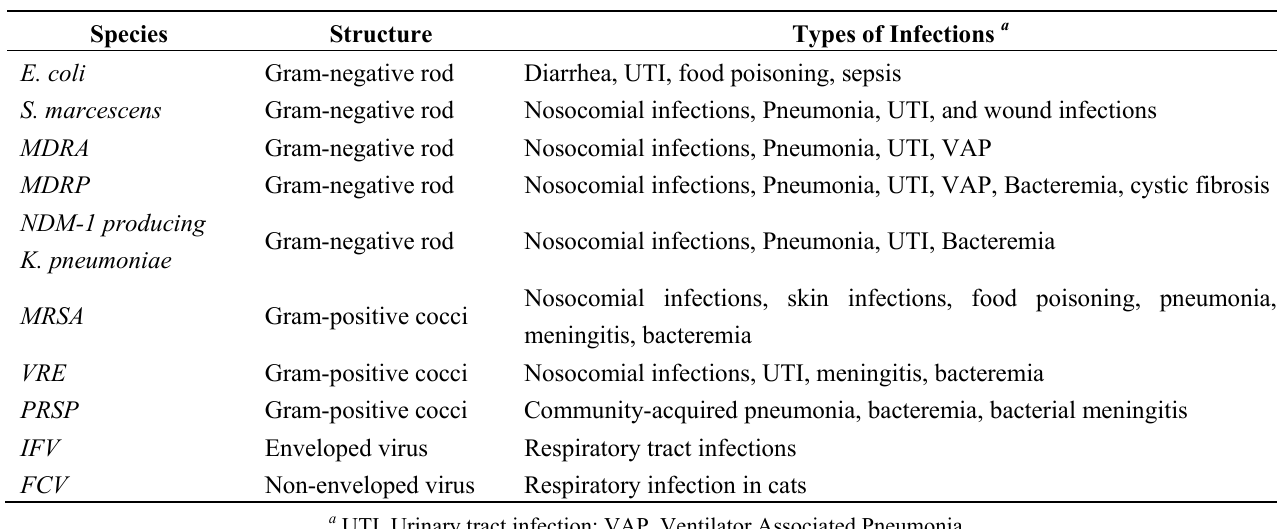
Table 2. Profiles of the organisms tested in this